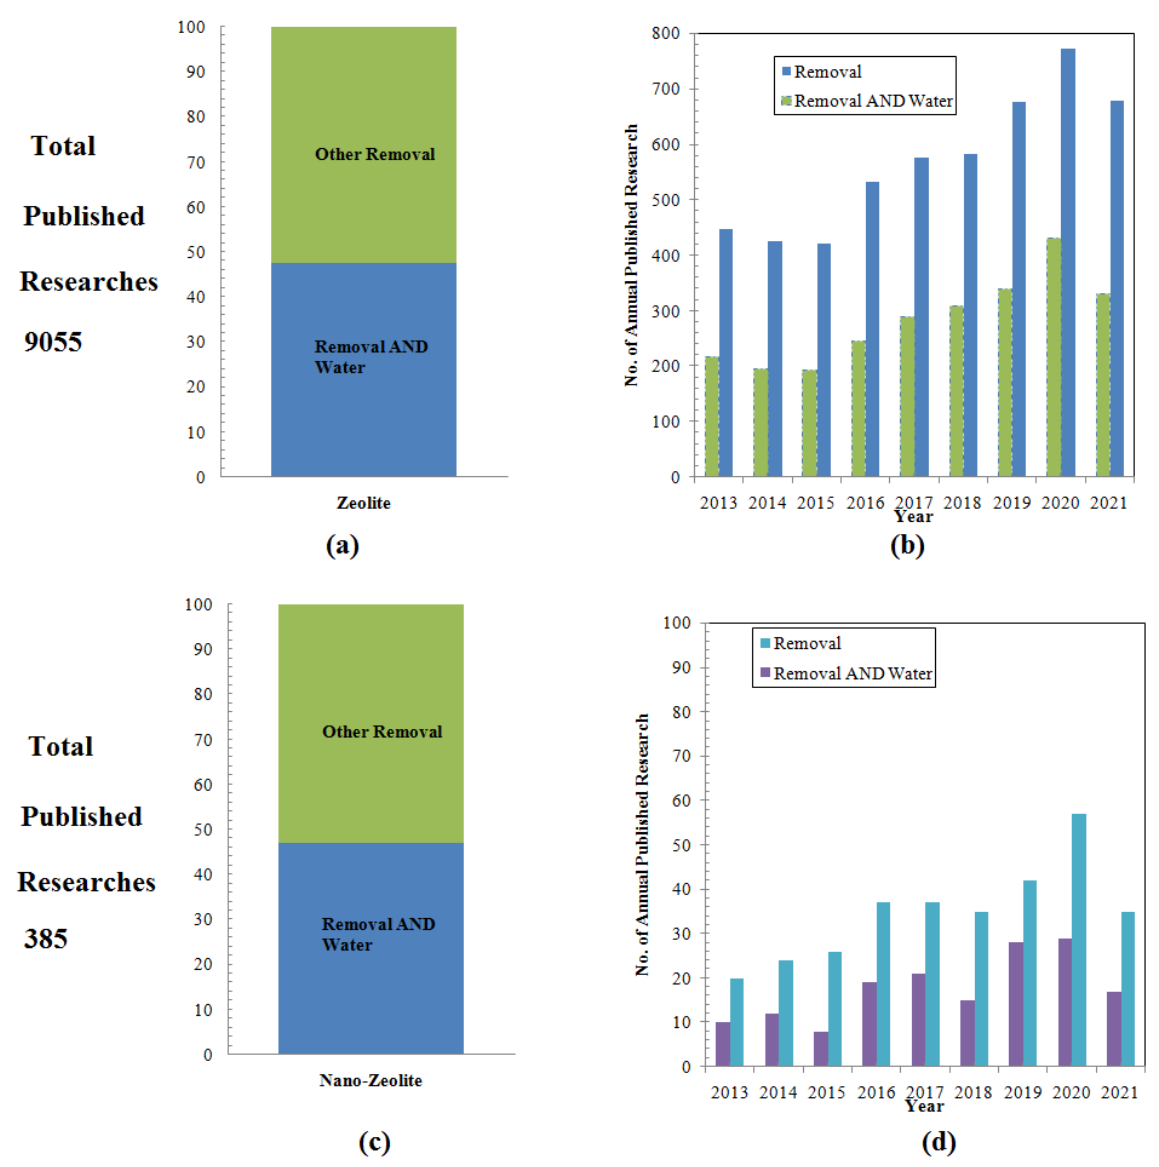
Figure 3. Analysis of the indexed work in the field of testing ( a ) Zeolite for “Removal” and “Removal AND Water Treatment”; ( b ) distribution of the total annual research for zeolites over the period (2013–2021); ( c ) Nano-zeolite for“Removal” and “Removal AND Water Treatment”; ( d ) distribution of the total annual research for Nano-zeolite over the period (2013 – 2021).